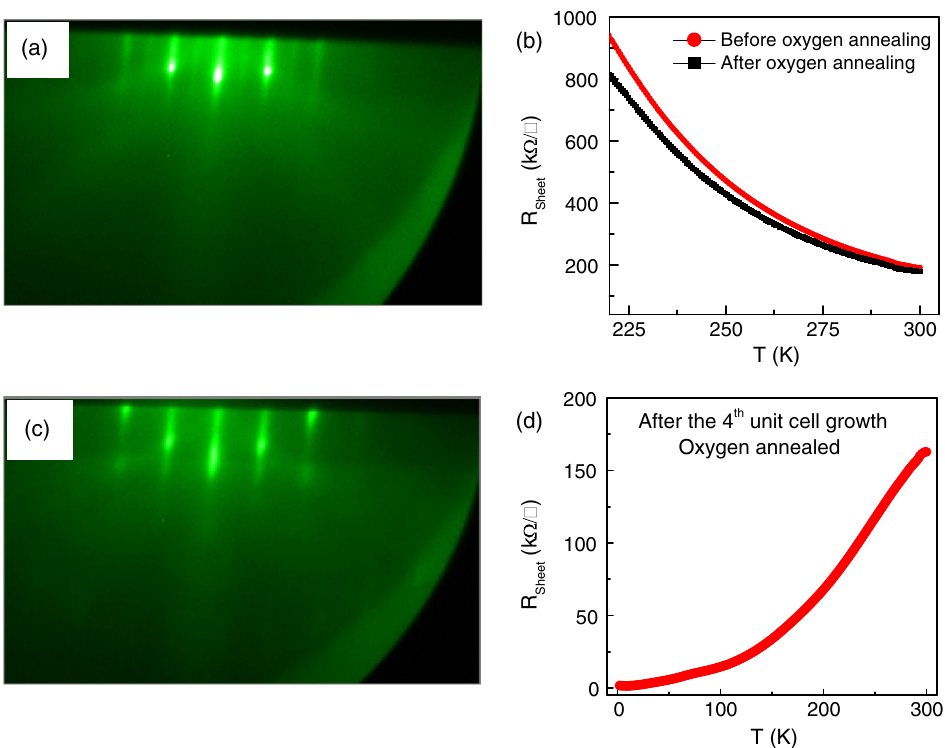
FIG. 6. Regrowth experiment. (a) RHEED pattern after depositing a new LAO layer (estimated to be 2 uc) on a crystalline LAO/STO heterostructure with the LAO layer etched from 4 uc to 3 uc. (b) R s - T curves of the regrown sample stated in (a) before and after oxygen annealing. (c) RHEED pattern after depositing 1-uc LAO on an as-grown 3-uc crystalline LAO/STO heterostructure. (d) R s - T curve of the regrown sample described in (c) after oxygen